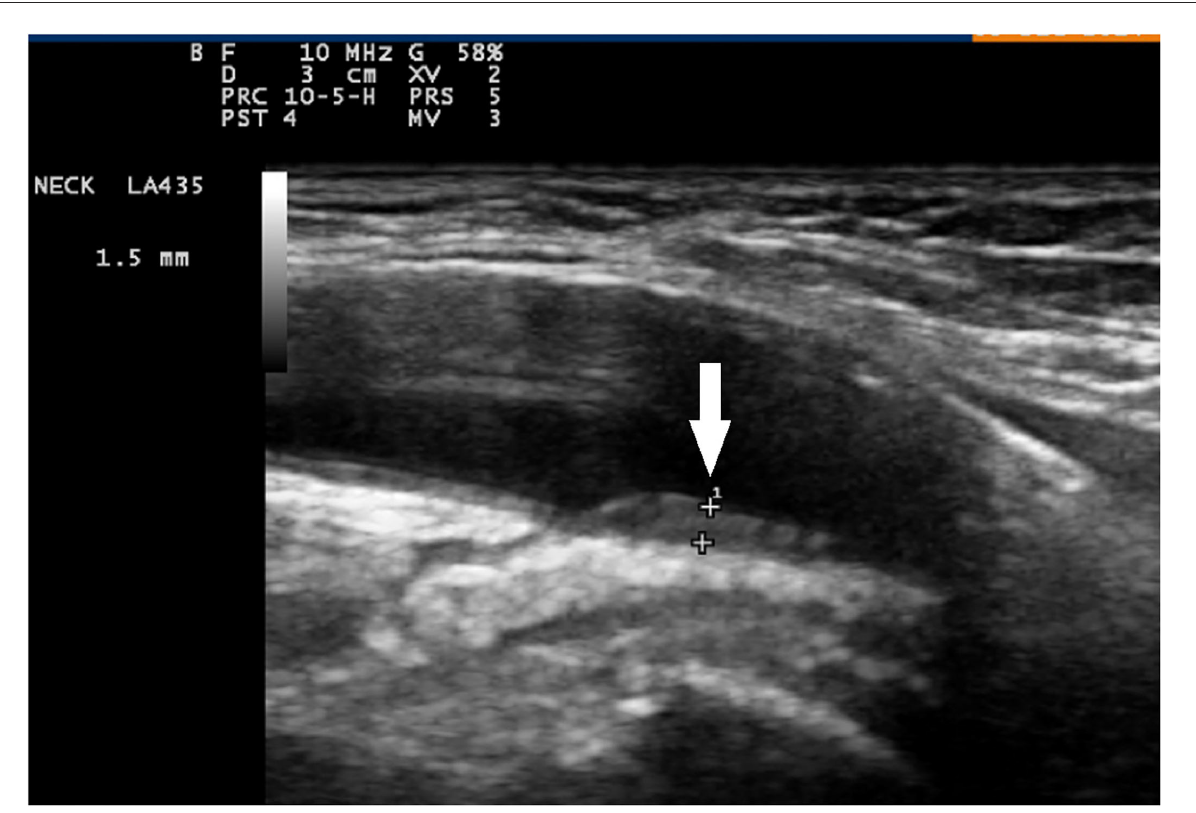
FIGURE1 Color duplex sonography of axillary artery and longitudinal plane. Signs of vasculitis in an axillary artery (arrow) sliding down to a normal intima-media in the brachial artery (slope